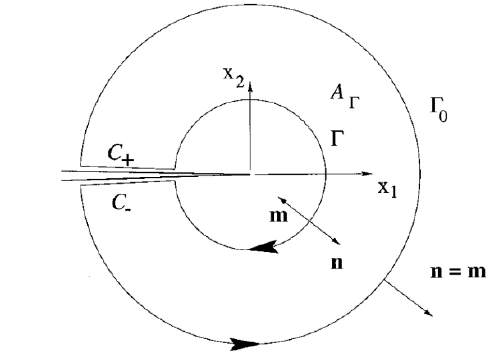
Figure 2. Equivalent domain for